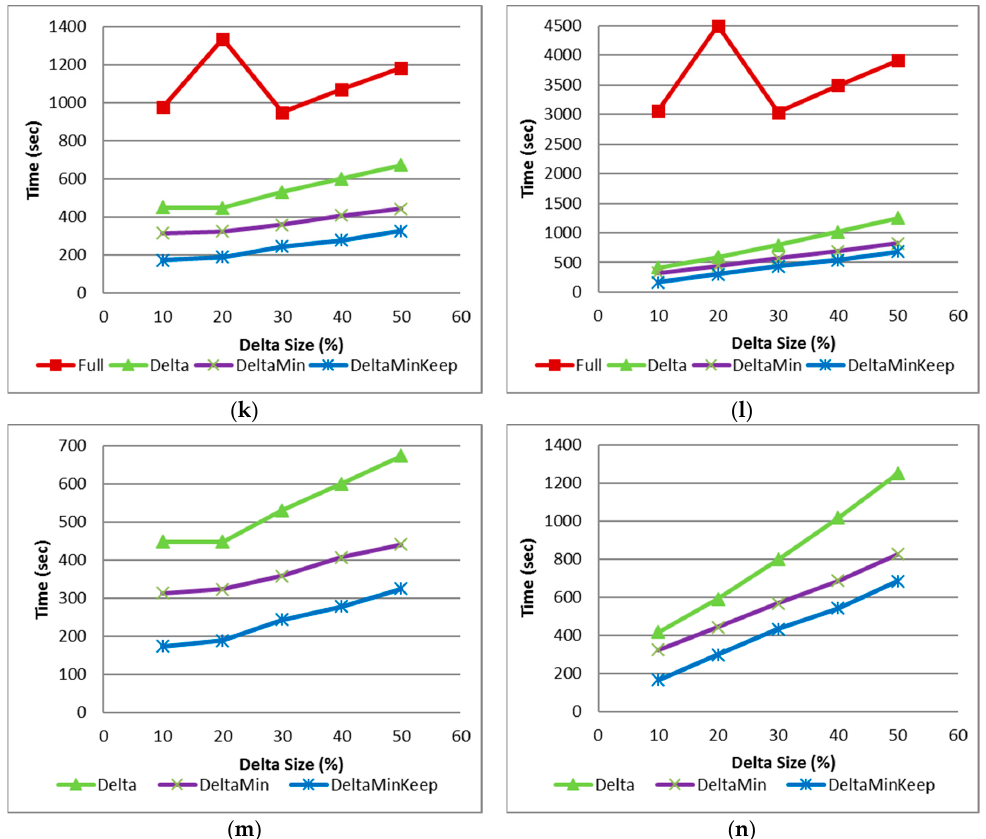
Figure 9. ( a ) T20 Run Time minSup 0.1% Cluster 5; ( b ) T20 CPU Time minSup 0.1% Cluster 5; ( c ) T20